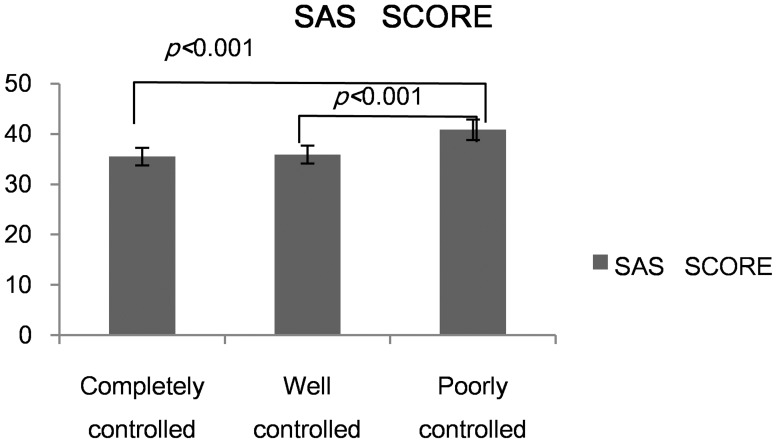
Anxiety score across different asthma groups.